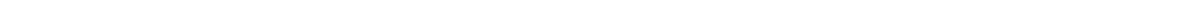
Fig. 2 Wnt/ β -catenin signaling is mainly active in fi broblast-like cells after spinal cord lesion. a Cartoon showing relevant transcriptional read-outs of Wnt/ β -catenin pathway activity, feedback regulatory mechanisms and strategies to interfere with signaling at different levels of the pathway. Abbreviation: β -cat., β -catenin. b Detection of gfp mRNA in the 6xTCF :dGFP transgenic reporter line shows transient activity of the Wnt/ β -catenin pathway in the lesion site during regeneration. c gfp expression is largely con fi ned to the lesion edge in 6xTCF :dGFP transgenic larvae (arrow). A few additional cells are labelled within the presumptive spinal cord region ( empty arrows ). Abbreviations: nc, notochord; sc, spinal cord; fi n, dorsal fi n fold. d The 6xTCF :dGFP Wnt reporter is mostly active in subepidermal p63 − cells ( arrows ; ≥ 69% of all 6xTCF :dGFP + cells at 1 dpl and 2 dpl), but also in p63 + basal keratinocytes ( arrowheads ) in the lesion site. # indicates non-speci fi c signal. e Consistent with a fi broblast identity, subepidermal cells (below dashed line ) co-express col1a2 ( red ) and gfp mRNA ( green ) in a lesioned 6xTCF :dGFP transgenic animal ( arrow ). Dashed line indicates junction between basal epithelium and adjacent connective tissue. f Fibroblast-like (6xTCF :dGFP + /p63 − ) cells are found in close proximity to regenerating axons (anti-acetylated Tubulin + ) in the spinal lesion site at 1 dpl ( arrows ). A single optical section is shown. a – f Views are lateral ( b , c , f ; dorsal is up , rostral is left ) or transversal ( d , e ; dorsal is up ) as indicated. BF: bright fi eld. Scale bars : whole mounts, 100 µ m b , c and 25 µ m f ; sections: 100 µ m. Error bars indicate